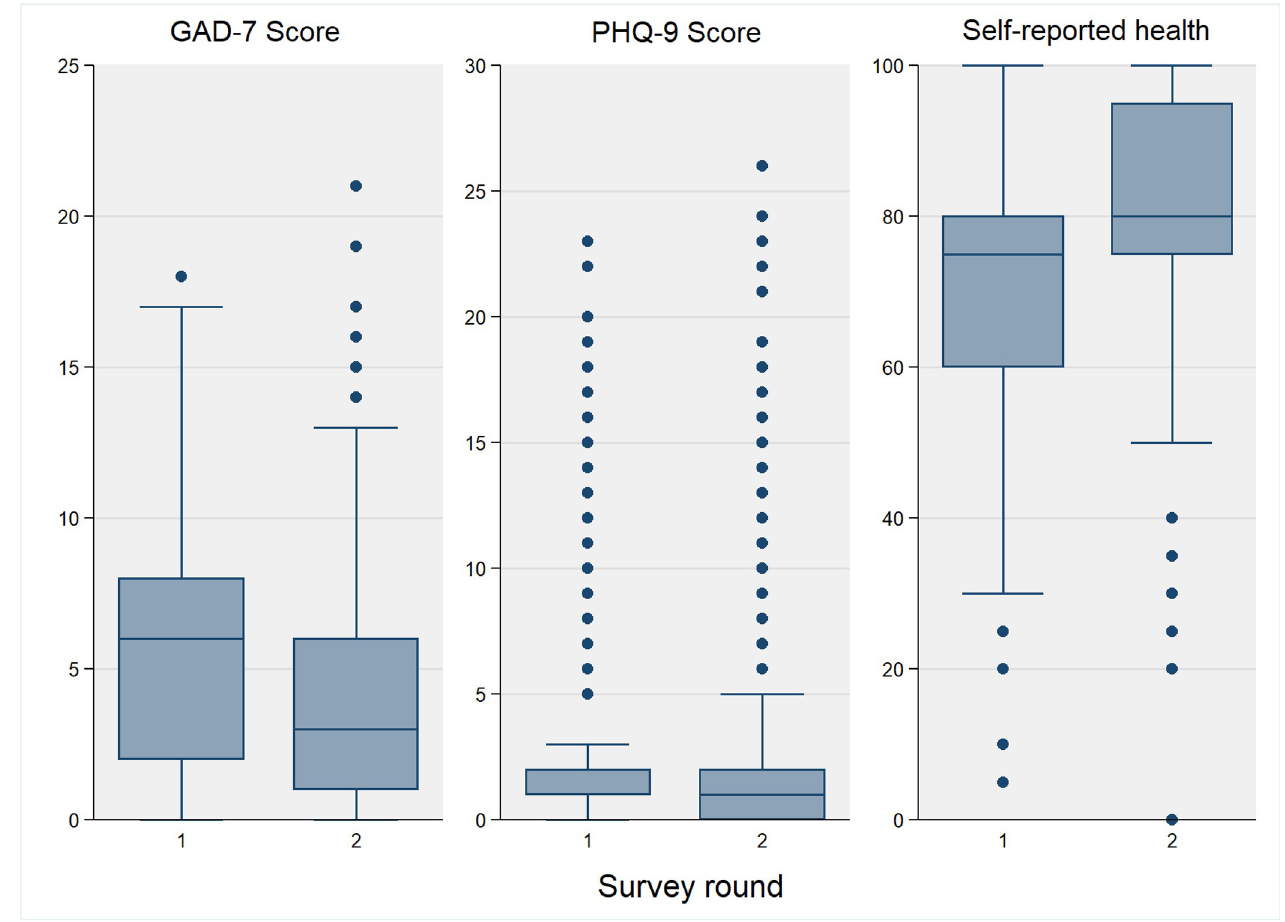
Fig 3. Change in self-reported health, GAD-7 an PHQ-9 between survey 1 and